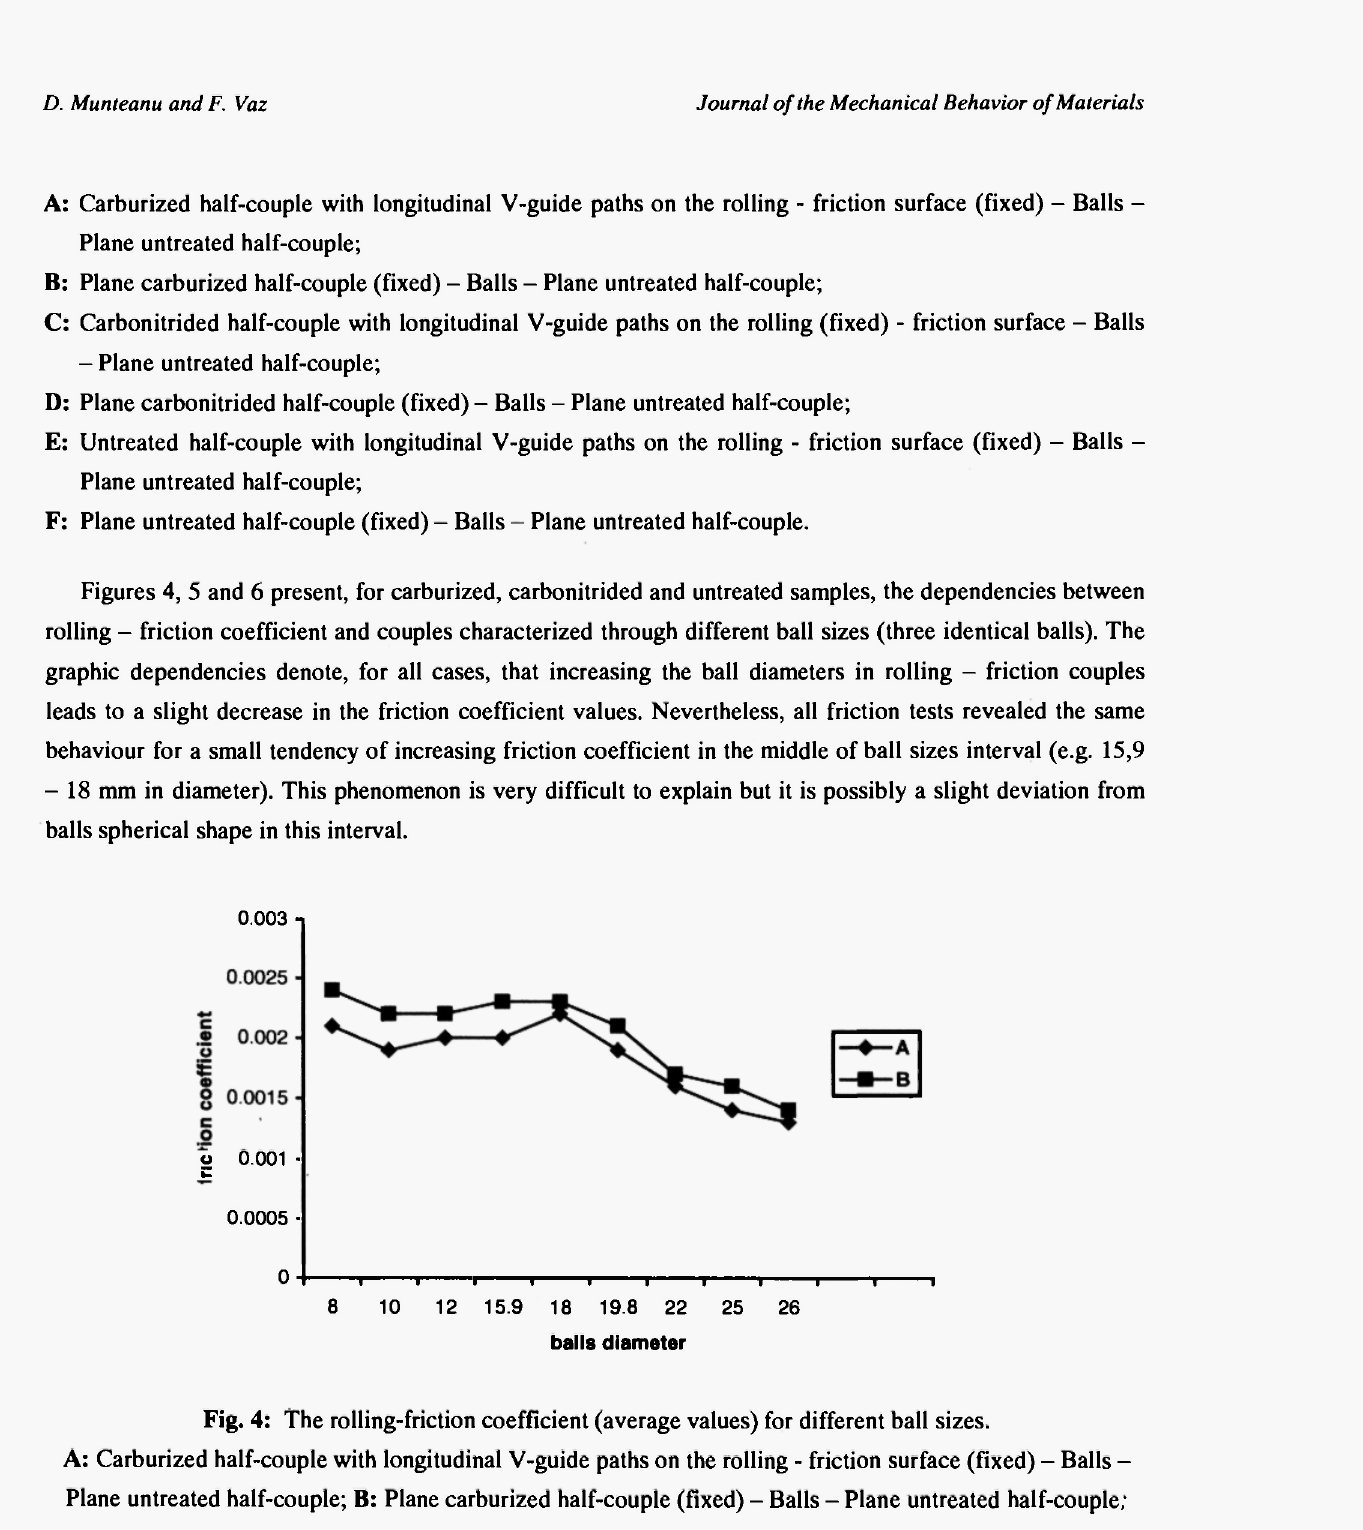
Fig. 4: The rolling-friction coefficient (average values) for different ball